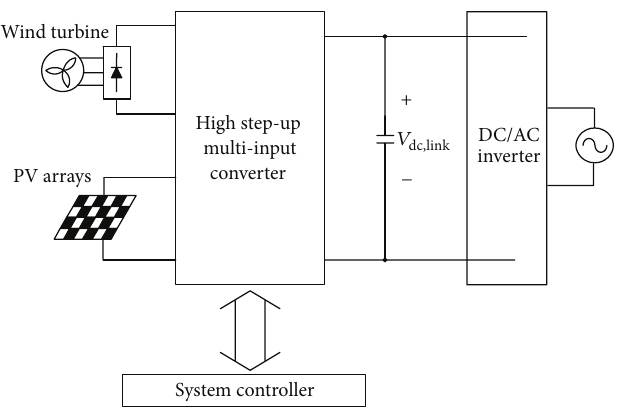
Figure 4: A block diagram to represent the configuration of the proposed MIC.